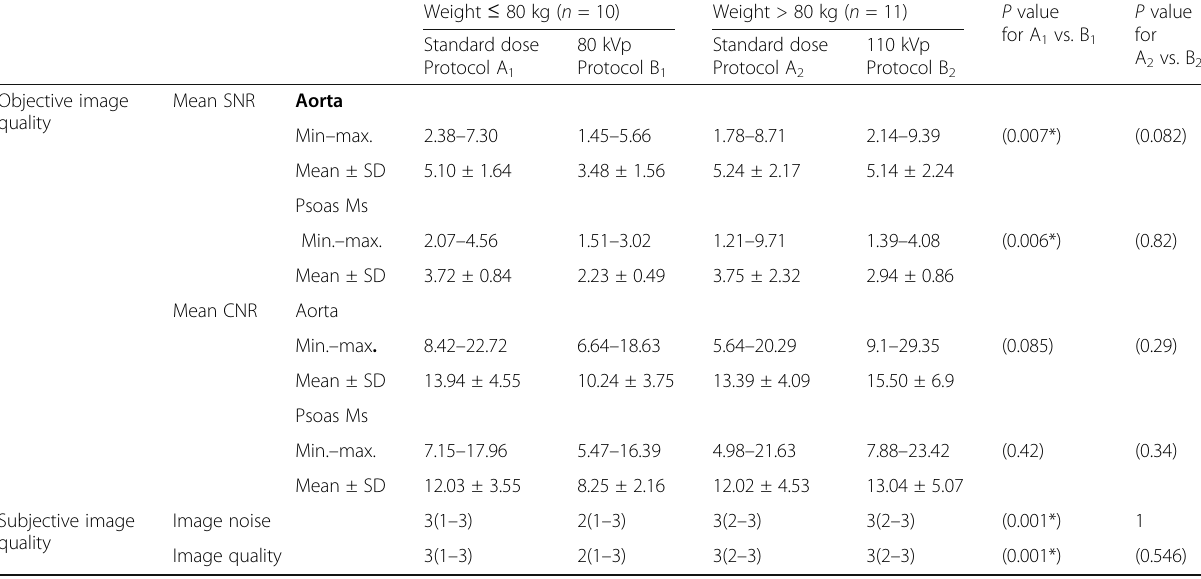
Protocol A2 vs. Protocol B2: No significant differences were seen between protocol A ≤ Table 3 Descriptive analysis of the studied cases according to mean objective image quality and subjective image quality